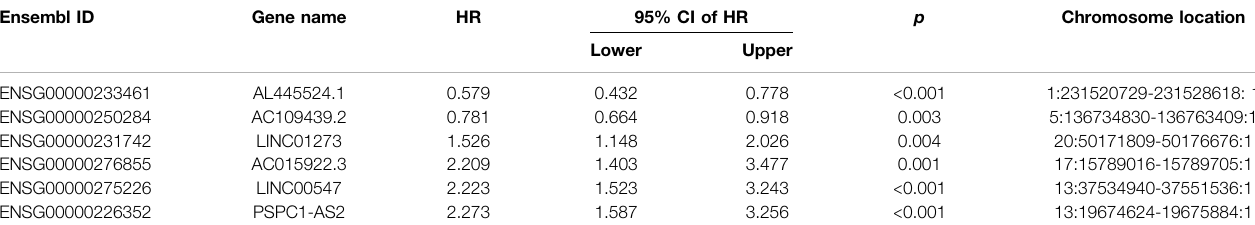
TABLE 2 | Prognostic signi fi cance of the six lncRNAs in the signature.